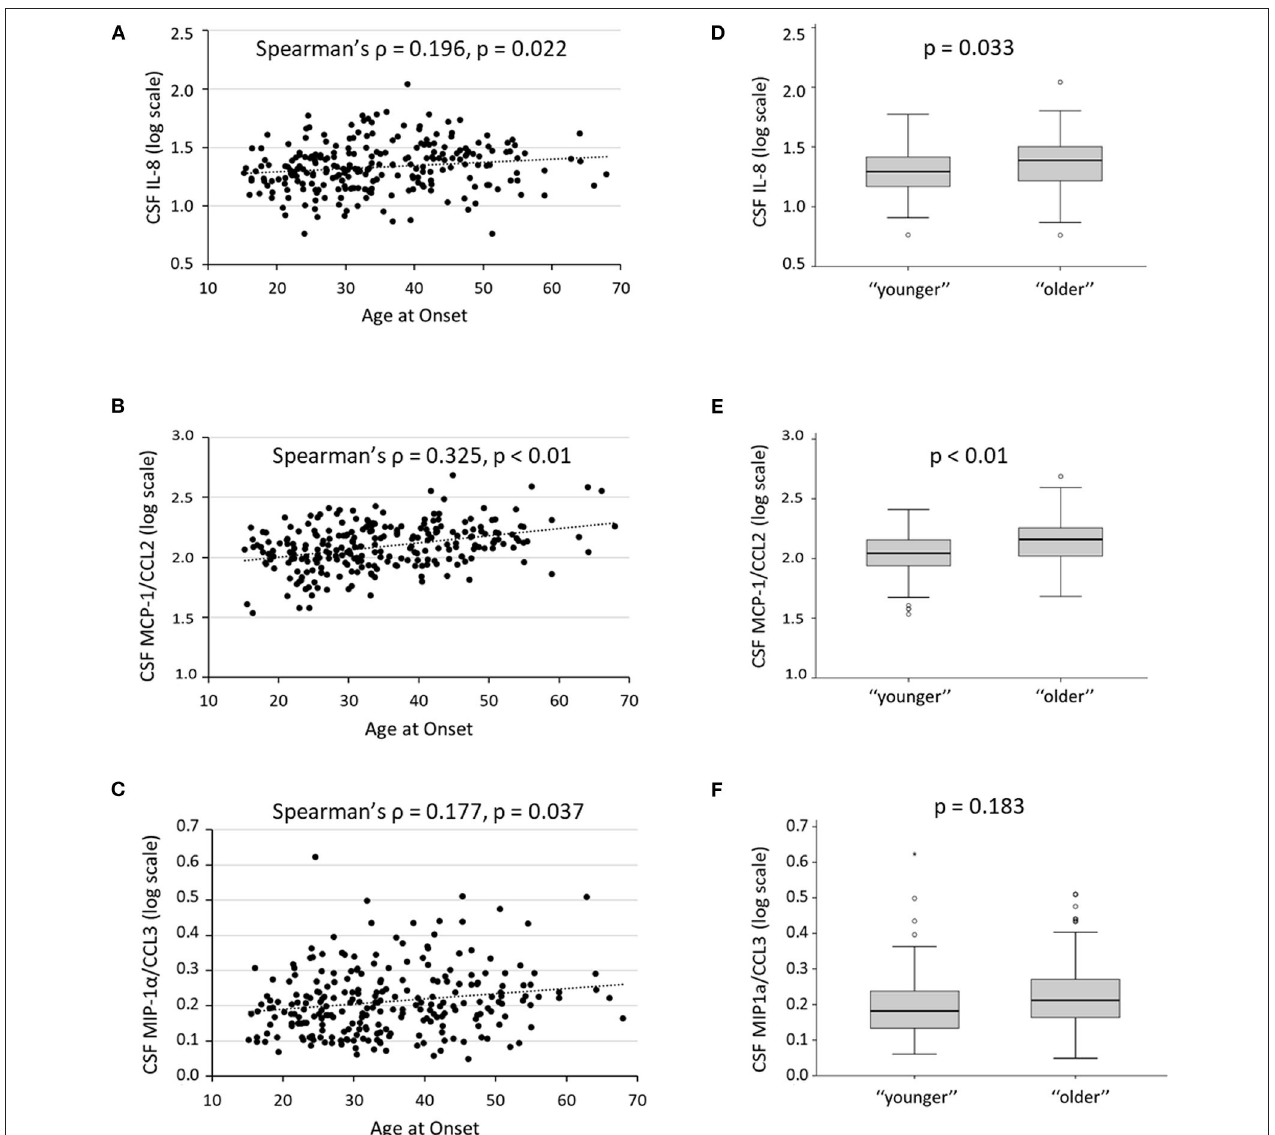
FIGURE 3 | Age and CSF inflammation. (A–C) Correlations between age at onset and CSF levels of IL-8, MCP-1, and MIP-1 α ; Spearman’s ρ and B–H adjusted p -values are shown. (D–F) CSF levels of IL-8, MCP-1, and MIP-1 α , in “younger” and “older” patients with MS; the B–H adjusted p -values of the Mann–Whitney U test are shown. To obtain a better graphical representation, CSF cytokines concentrations are shown on a logarithmic scale. B–H, Benjamini–Hochberg; CSF, cerebrospinal fluid; IL, interleukin; MCP-1, monocyte chemoattractant protein 1; MIP-1 α , macrophage inflammatory protein